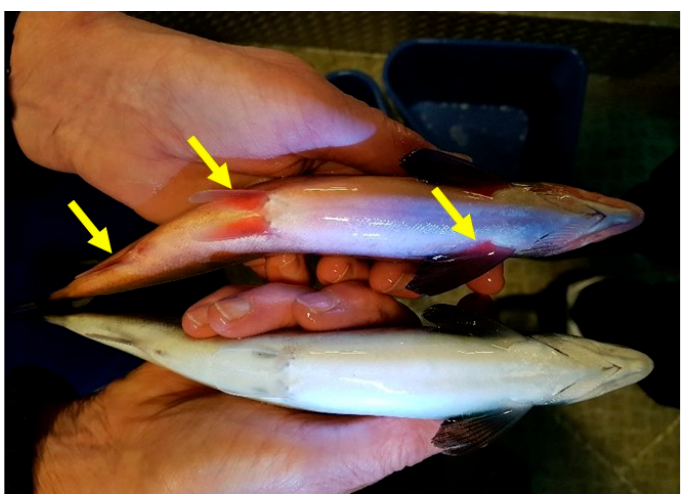
Figure 2. Salmon, both having suffered from acute salmon gill poxvirus disease (SGPVD). Note redness of the abdominal wall and fin of the upper fish (yellow arrows), a common finding in some individuals in SGPVD outbreaks.